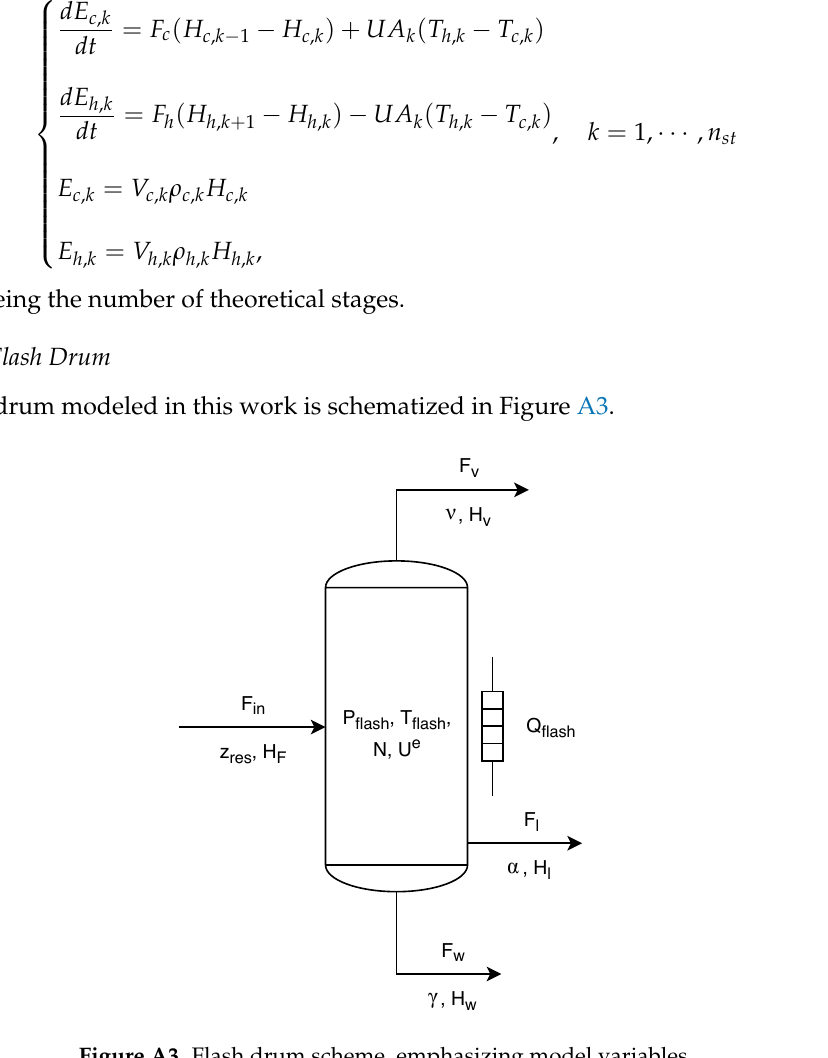
Figure A3. Flash drum scheme, emphasizing model